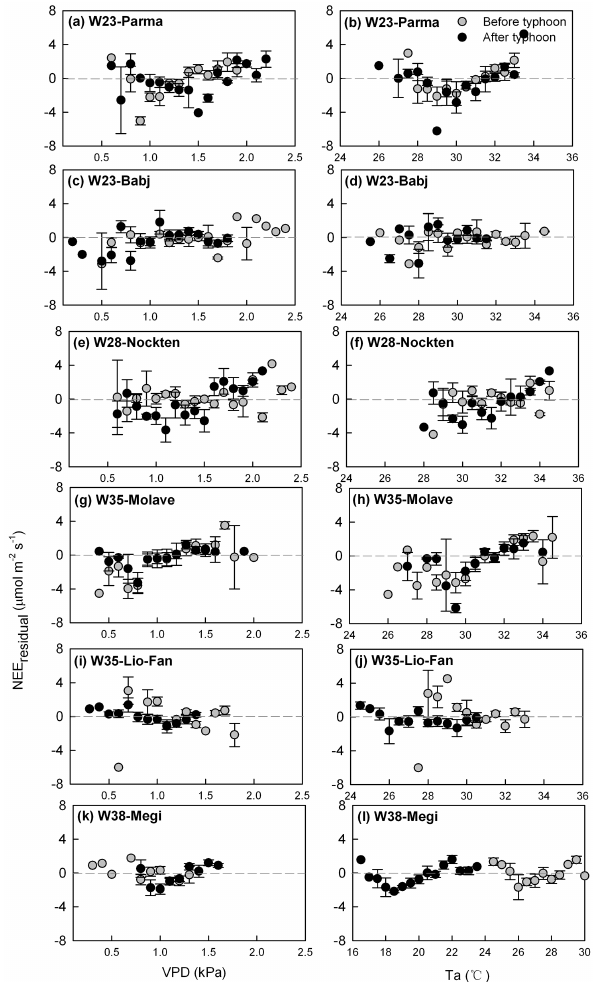
Figure 5. Residuals of daytime net ecosystem CO 2 exchange (NEE) at photosynthetically active radiation (PAR) as a function of vapor pressure deficit (VPD) and air temperature ( T a ) before and after a typhoon made landfall. Residual NEE was calculated by subtracting the NEE expected based on light response function using observa- tions (PAR >500) from the observed NEE.